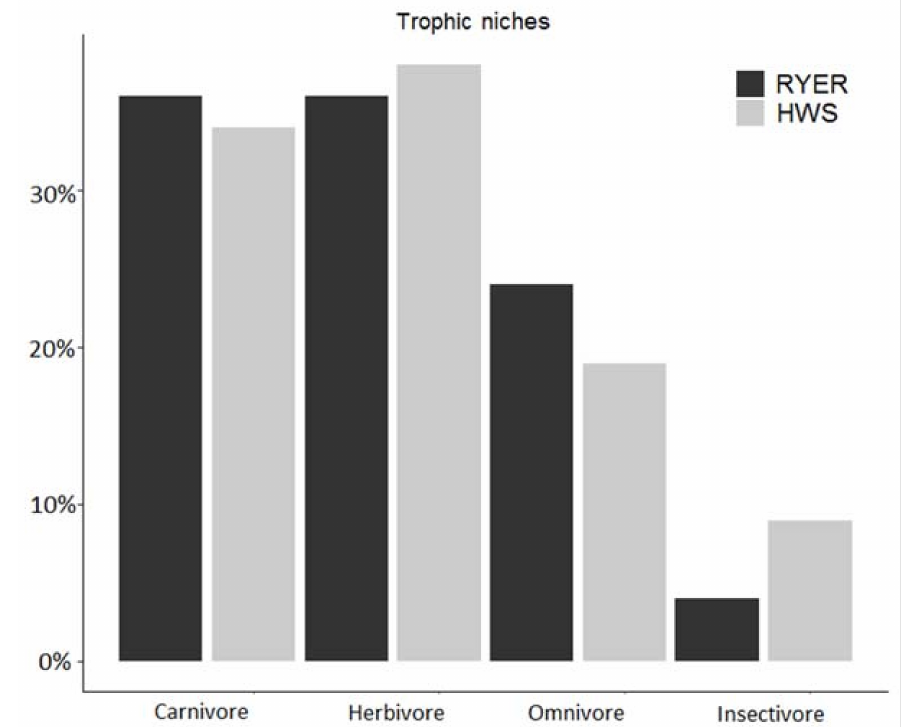
Figure 4. Proportion in % of each trophic niche compared to the total number of observed species in each community (Rakhine Yoma Elephant Range (RYER): black; Htamanthi Wildlife Sanctuary (HWS): grey).